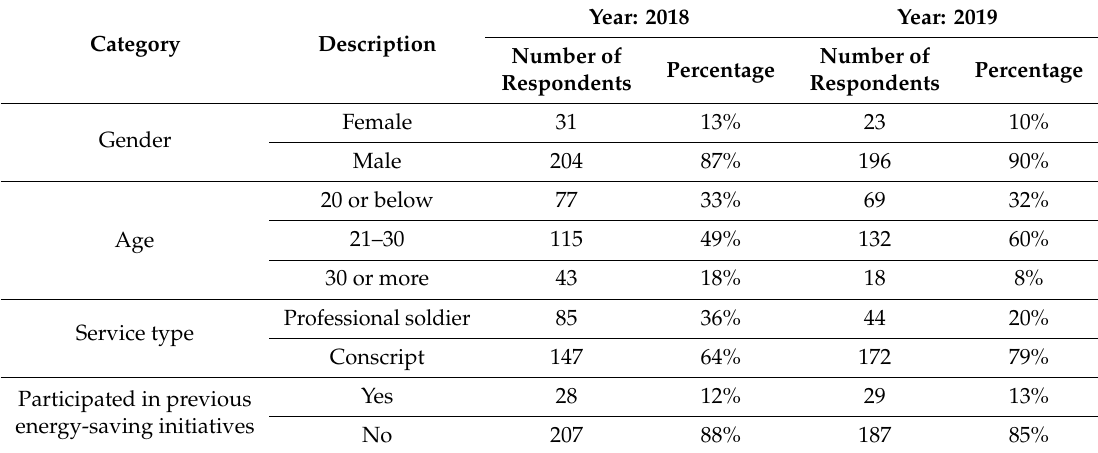
Table 1. Demographic information of the